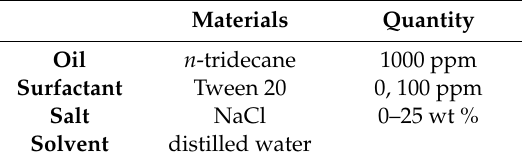
Table 2. Compositions of the oil–water